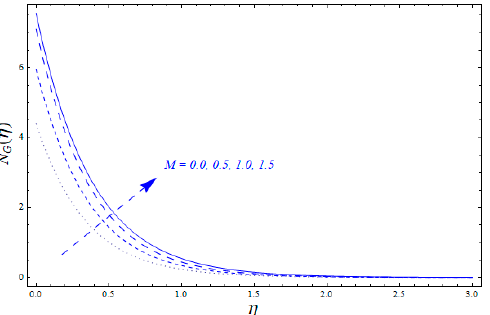
Figure 18. Upshot of M on N G ( η ).